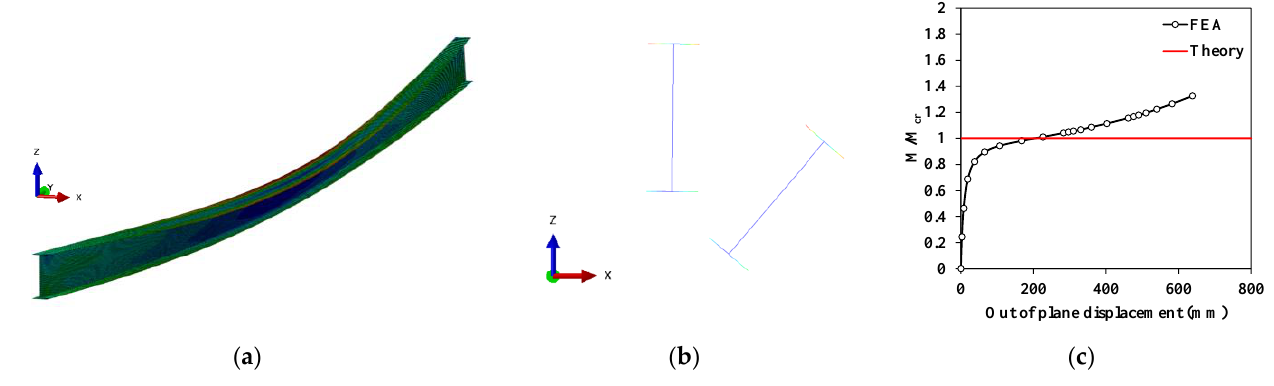
Figure A1. Preliminary analysis of W920 × 201 with the initial imperfection of 𝐿 𝑏 /2000: ( a ) deformed shape of the girder; ( b ) deformed shape of mid-section; and ( c ) a normalized loading and out-of-plane displacement (x-direction) relationship.